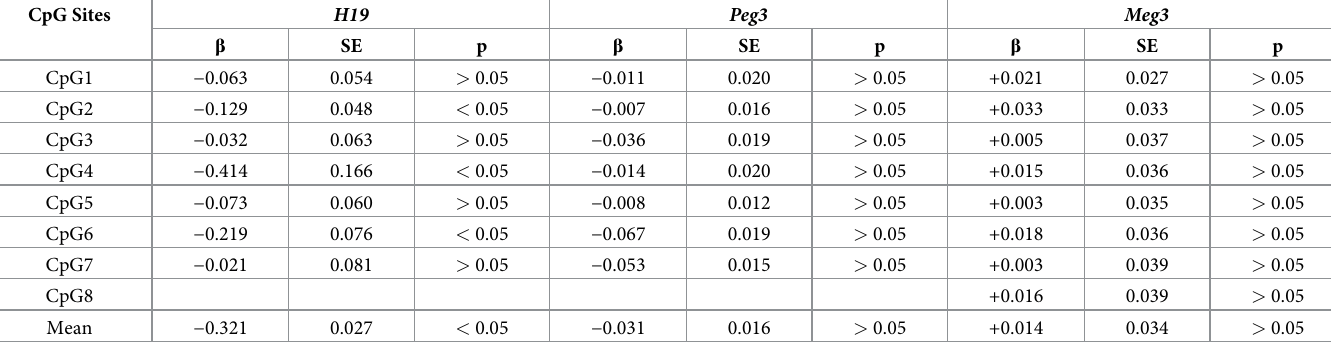
Table 5. Multivariate regression analyses of imprinted genes H19 , Peg3 and Meg3 and urinary Hg. CpG